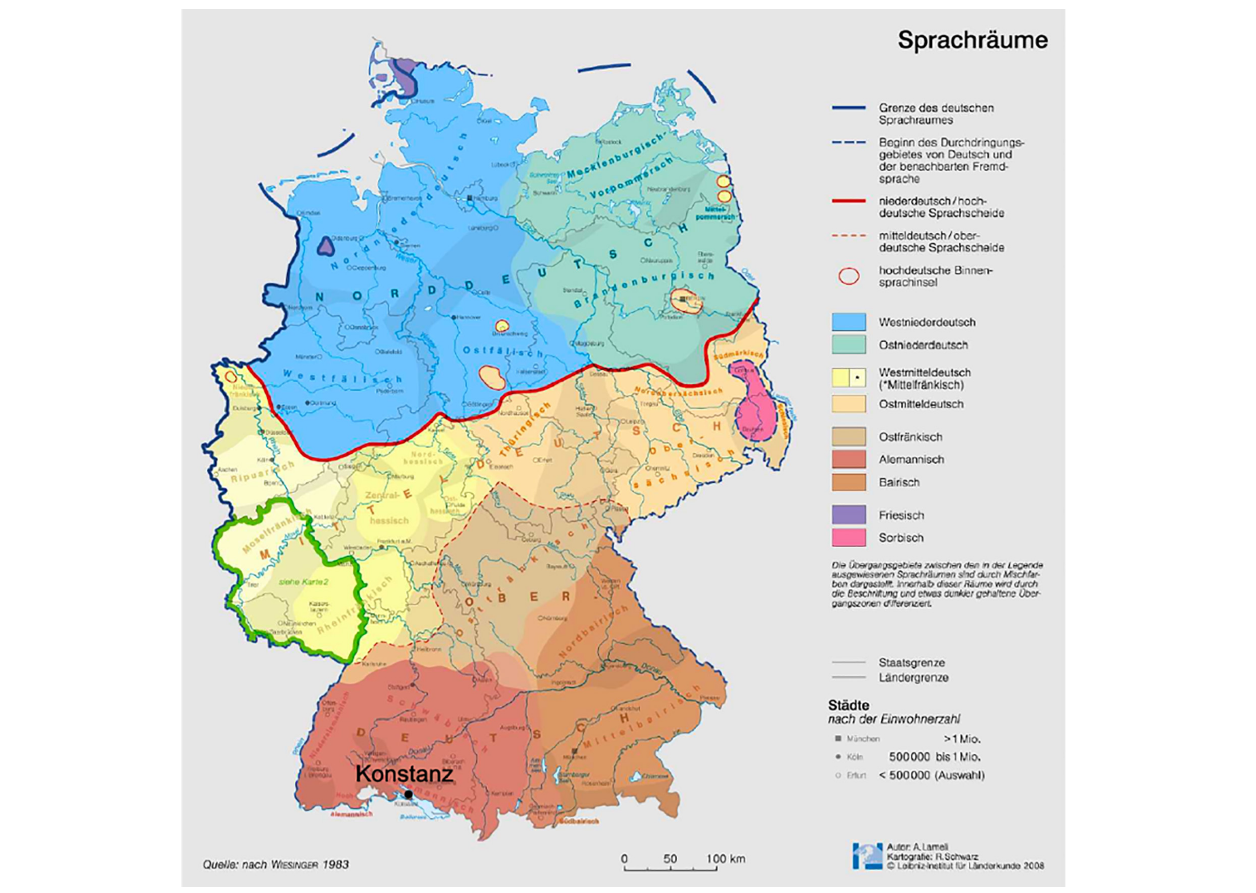
FIGURE 1 | Map of German dialects (http://aktuell.nationalatlas.de/Dialektraeume.9_08-2008.0.html/). The relevant dialect areas in the South of Germany translate as follows: Schwäbisch “Swabian,” Mittelalemannisch “Alemannic,” Mittelbayrisch “Middle Bavarian.” Reprinted with permission of Alfred Lameli.